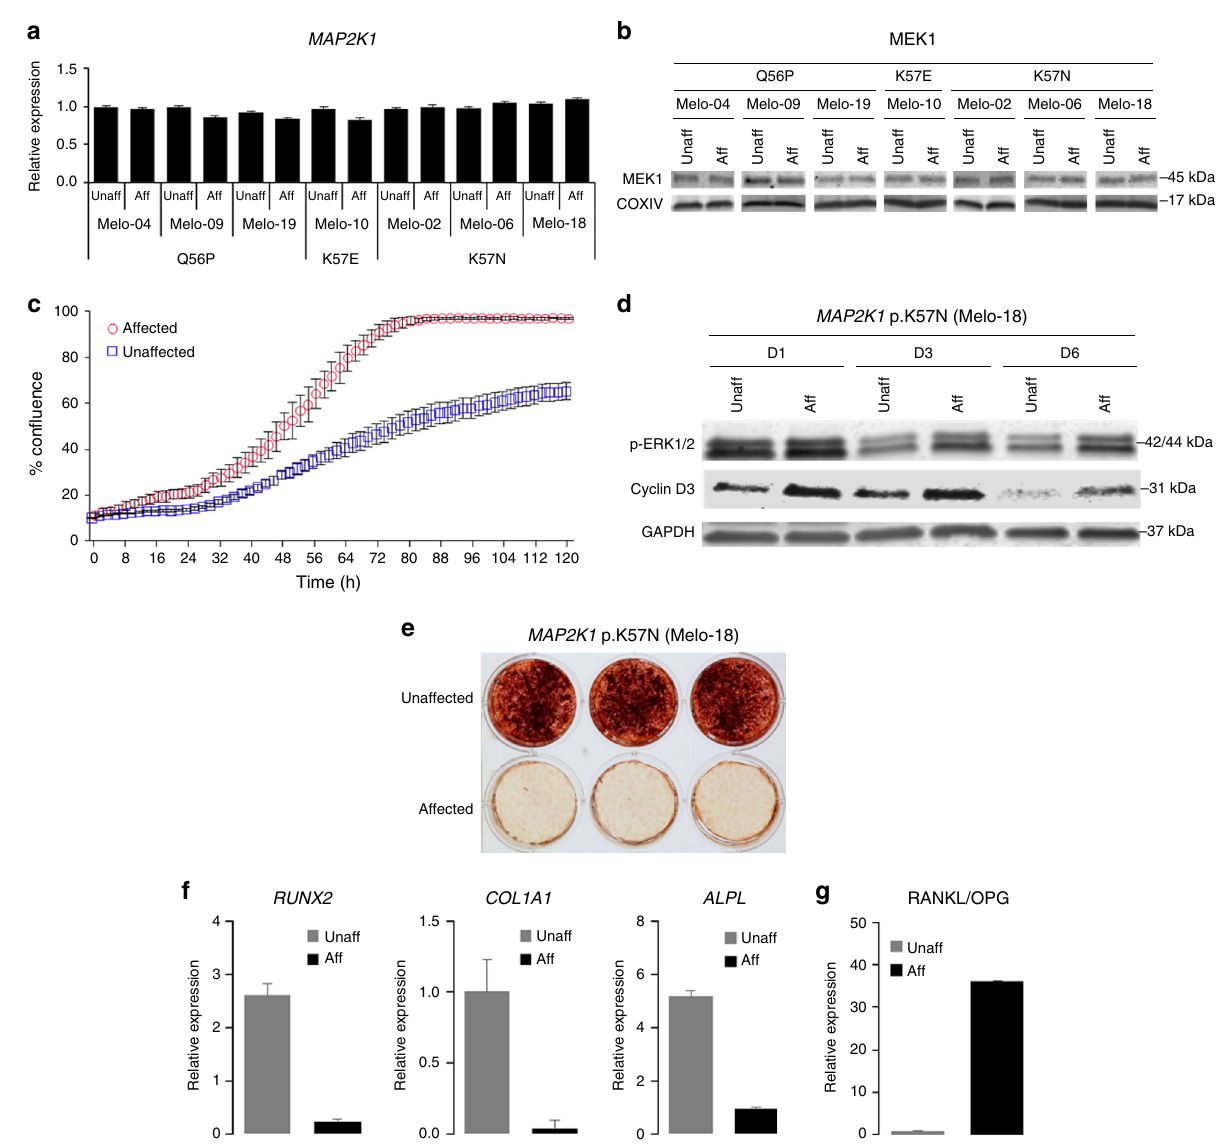
Fig. 5 Increased cell proliferation and delayed osteoblast differentiation and mineralization by MAP2K1 mutations. a MAP2K1 variants found in seven melorheostosis patients do not affect the levels of MAP2K1 transcripts. There was no statistically signi fi cant difference in MAP2K1 transcript levels between affected and unaffected osteoblasts (* p < 0.05, paired t -test). Real-time qPCR was carried out in triplicate for each patient sample. b Western blot analysis displays comparable levels of MEK1 protein in affected and unaffected osteoblasts. c Cell proliferation assay using live-cell imaging. Affected and unaffected osteoblasts from melorheostosis patient, Melo-2 ( MAP2K1 p.K57N, VAF 45%) were plated at various densities (1000~5000 cells/well) ( n = 30). Percent cell con fl uence is shown at 2-h intervals with symbols indicating mean of replicates (error bars: SEM). Doubling time calculated from the linear phase growth yielded a doubling time of 18 h for affected osteoblasts compared to 54 h for unaffected. Results are representative of two independent experiments. ( p < 0.0001). d Western blot analysis shows that affected osteoblasts (lanes 2, 4, and 6) expressed higher level of cyclin D3 compared to unaffected (lanes 1, 3, and 5), correlating with the increased p-ERK1/2 level in affected cells shown in Fig. 4c. Note that levels of cyclin D3 and p-ERK1/2 decreased on day 3 (D3) and day 6 (D6) compared to day 1 (D1), because culture media was not refreshed after day 1, similar to conditions used during the live-cell imaging shown in Fig. 5c. e Alizarin Red S staining of mineralization in osteoblast cultures from patient Melo-18 ( MAP2K1 p.K57N, VAF 46%). After 7 weeks of BMP2-stimulated mineralization in vitro, signi fi cantly inhibited mineralization was observed in affected cells compared to unaffected. f Real- time qPCR analysis of expression of osteogenic marker genes, RUNX2 , COL1A1 , and ALPL in osteoblasts from melorheostosis patient Melo-2 ( MAP2K1 p. K57N, VAF 45%) after two weeks of osteogenic stimulation. Expression level of RUNX2, COL1A1, and ALPL was signi fi cantly lower in affected osteoblasts compared to unaffected. g The RANKL/OPG transcript ratio, an index of osteoclastogenic stimulus, was assessed by real-time qPCR with Melo-2 patient osteoblasts as in Fig. 5f. Signi fi cantly higher ratio of RANKL/OPG in affected osteoblasts indicates increased osteoclastogenesis compared to melorheostosis patients has recently been reported in endothelial, While the MAPK pathway is known to be involved in skele- but not skin or blood, cells of patients with extracranial arter- togenesis and MEK1 is essential in embryogenesis, our study iovenous malformations (AVM) 25 . Similar to melorheostotic bone documents the importance of the MEK1-ERK1/2 pathway in lesions, AVM lesions caused by MAP2K1 mutations expand but do human bone cell biology. While somatic mutations in MAP2K1 not metastasize. have also been reported in Langerhans cell histiocytosis and